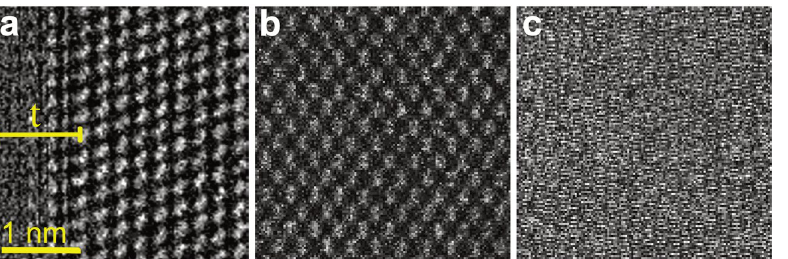
Figure 2. STEM images acquired along a [110] Si using different acquisition routines. ( a ) 128 × 128 raster scan with a dwell time T D = 10 μs, but no flyback time showing image distortions. ( b ) The addition of τ prevents image artifacts. ( c ) Raw image acquired with a serpentine